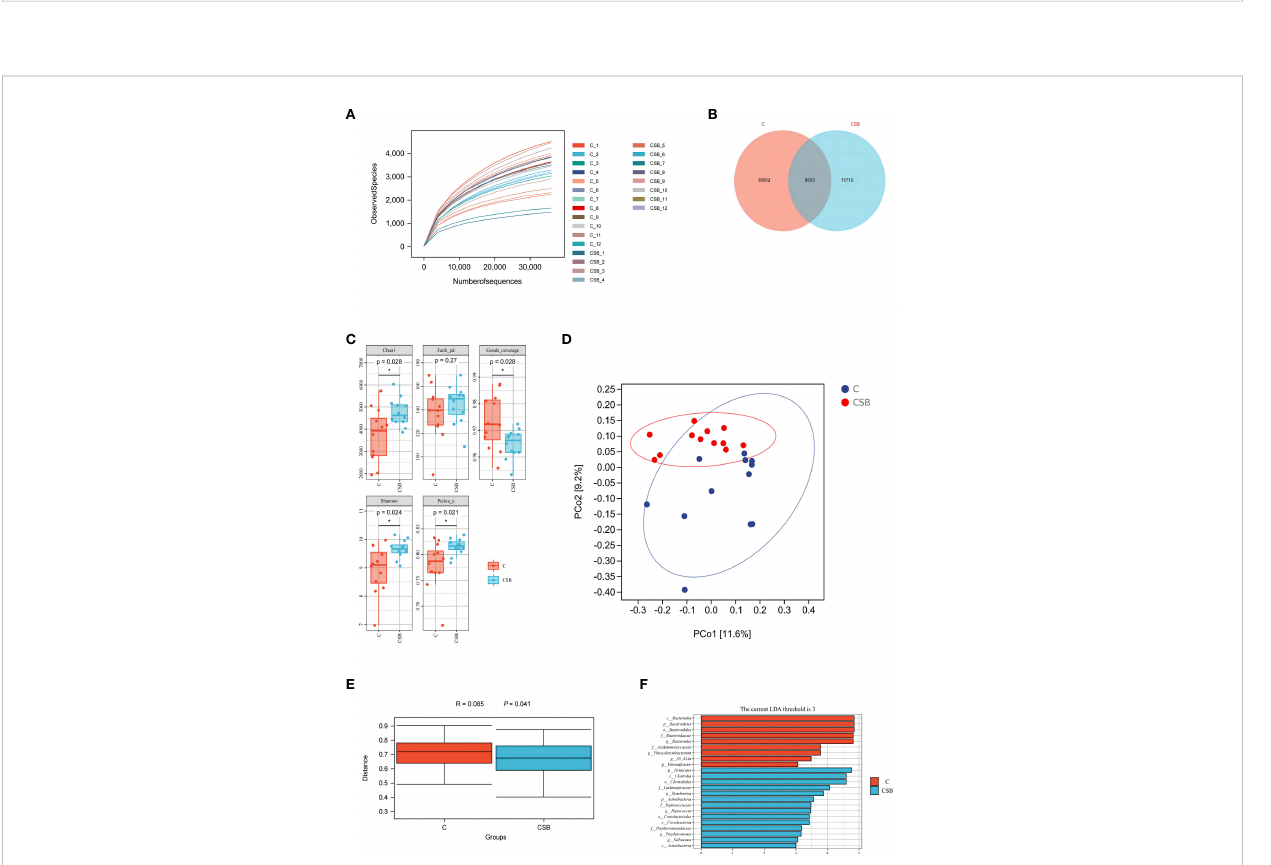
FIGURE 7 Effects of dietary supplementation of coated sodium butyrate (CSB) on cecum microbiota in laying ducks. (A) Rarefaction curves. (B) Venn diagram of the amplicon sequence variants (ASVs). (C) Chao1, Faith ’ s phylogenetic diversity (PD), Good ’ s coverage, Shannon, and Pielou ’ s evenness (Pielou-e) a -diversity indices. (D) principal coordinate analysis (PCoA) of taxonomical classi fi cations of the cecal bacterial communities. (E) weighted_unifrac distance. (F) linear discriminant analysis effect size (LEfSe) analysis (LDA threshold = 3). Values are presented as means ± SEM (n = 12). * p< 0.05. group C, Control group, which was fed a basal diet; CSB group, CSB-treated group, which was fed the basal diet supplemented with 250 g/t of